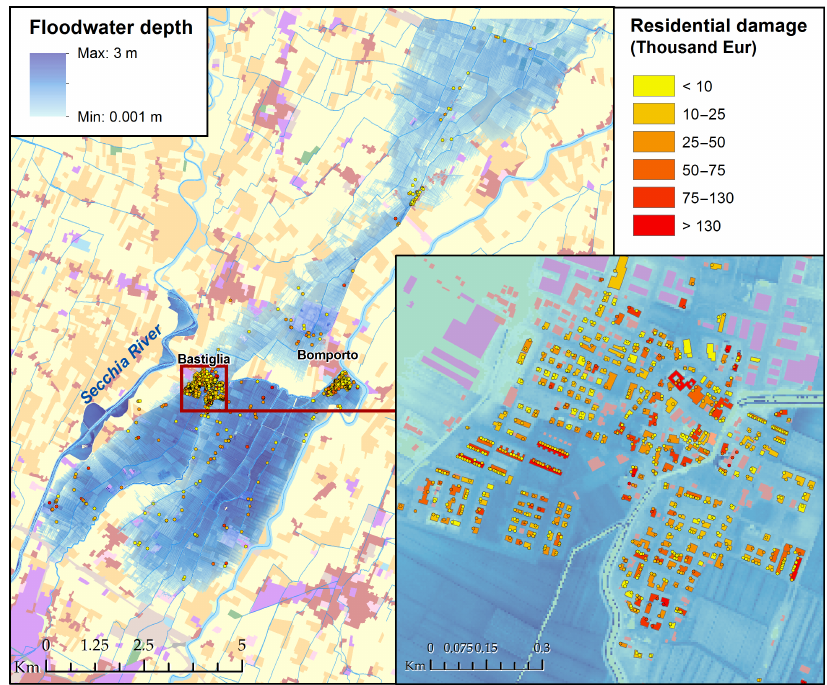
Figure 2. Visualization of the empirical damage records suffered by the individual dwellings during the flood event of 2014. Records are projected to official street number points by using their “address” field. The information is then transferred from the points to the building features that contains them. The point records that fall within the same building perimeter are summed up into one aggregated damage value for each residential building. About 97% of damage records are correctly projected. The remaining 3% of damage records are discarded due to inconsistent projection, incomplete address, or gaps in the record data. The colour gradient (yellow to red) indicates the magnitude of the damage for both individual points and building